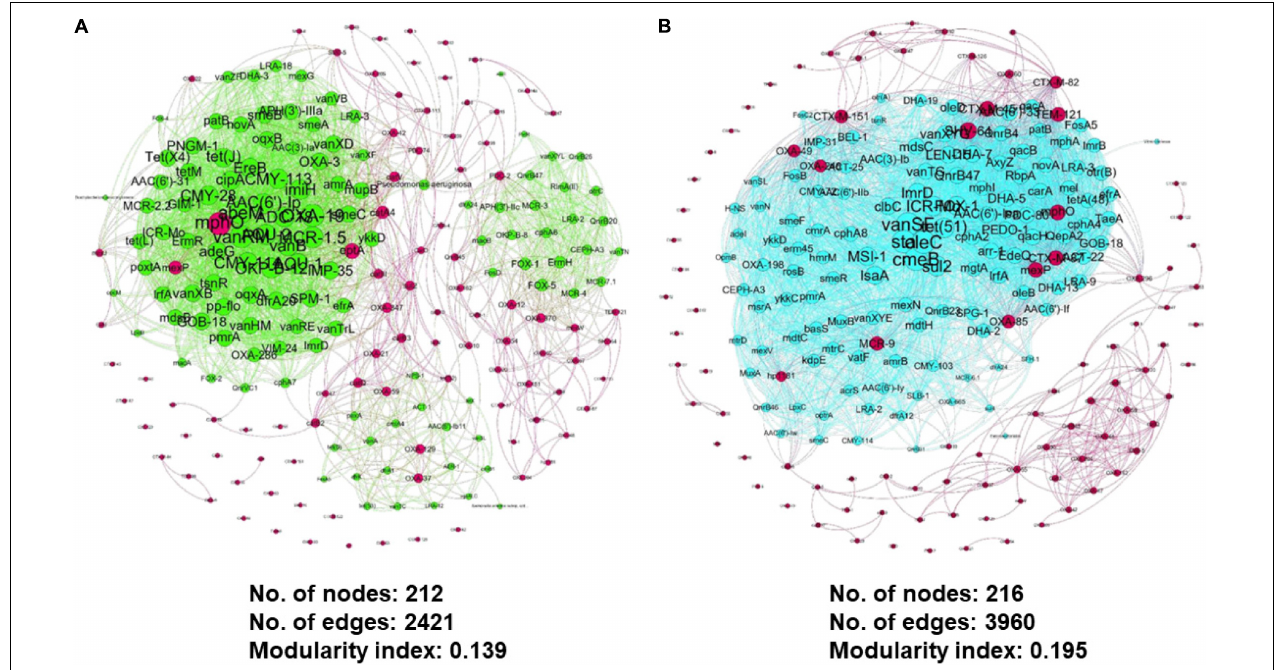
FIGURE 12 | Zoomed and filtered co-occurrence meta-network analysis from the previous global network showing the interaction between selected ARG from eight ARG family types and neighboring nodes in (A) influent and (B) effluent